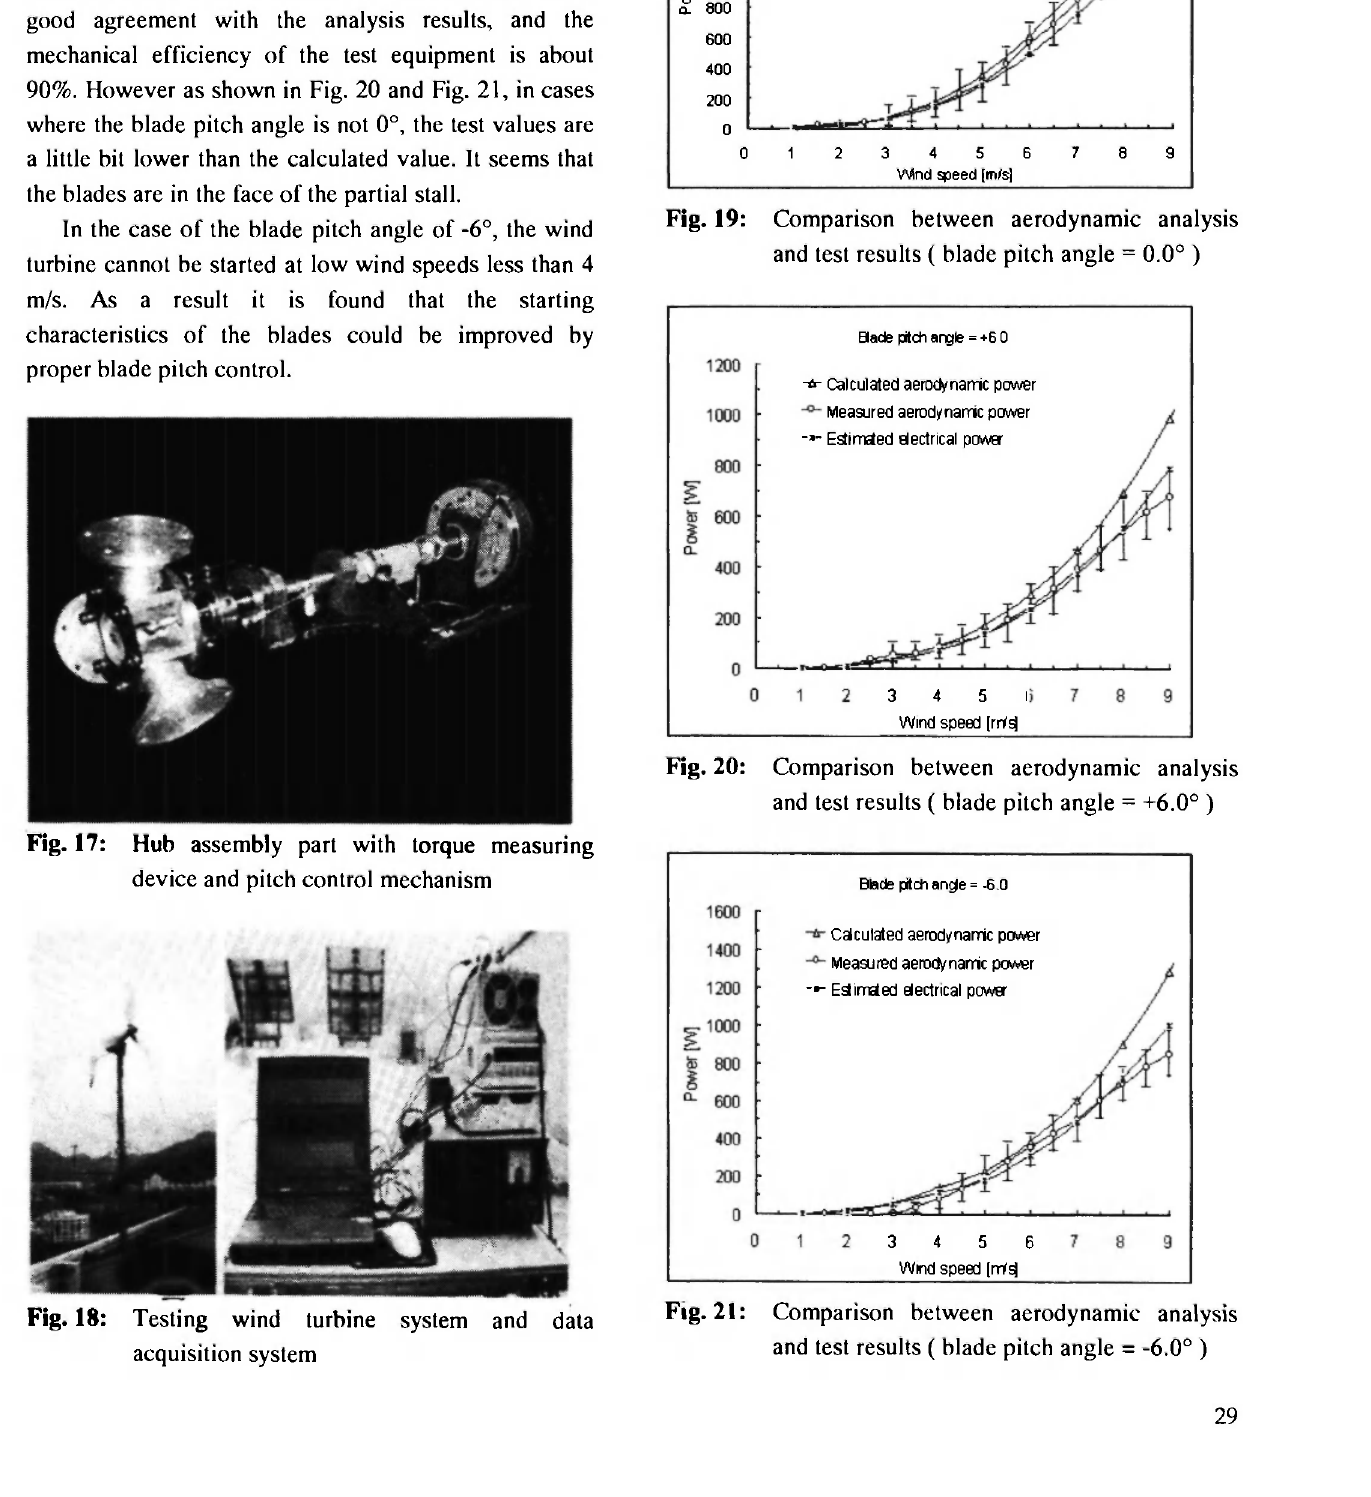
Fig. 19: Comparison between aerodynamic analysis and test results ( blade pitch angle = 0.0° )